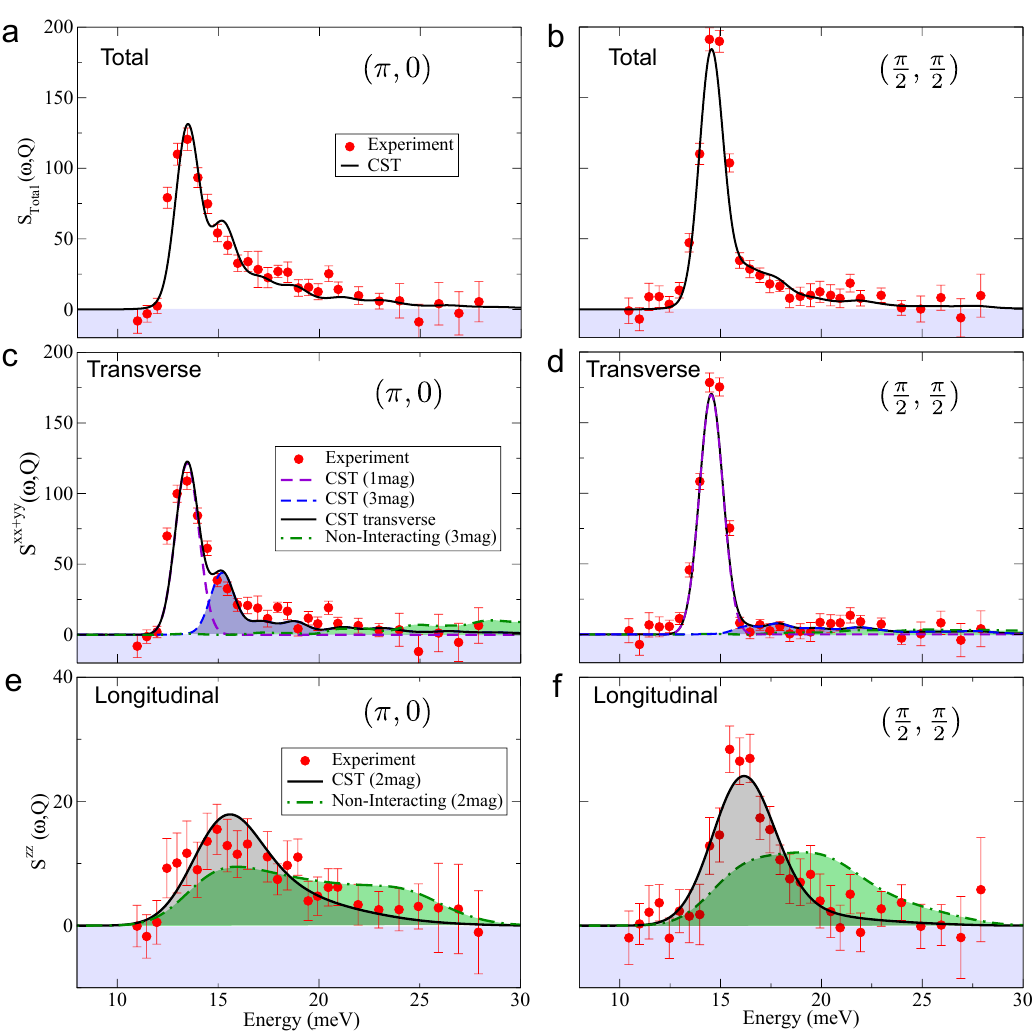
Figure 4: Dynamic structure factors. Comparison between the DSFs measured in Ref. [ 16 ] and the theoretical line shapes obtained from the CST. The energy scale is set to J = 6.11 ( 2 ) meV for all curves. The arbitrary units on the y -axis are fixed globally to match the experimental data. The lattice constant is set to unity. ( a ) Total DSF (sum of transver- π π ) . ( c ) Transversal DSF sal and longitudinal part) at k = ( π ,0 ) . ( b ) Total DSF at k = ( , 2 2 at k = ( π ,0 ) . The magenta line shows the dominant one-magnon peaks. The transversal = 0.58 ( 2 ) meV. The three-magnon continuum is shown as blue curve. broadening is set to σ t Omitting the interaction leads to the green curve which does not agree with experiment at all. π π ) ; otherwise same as in panel ( c ). ( e ) Longitudinal DSF at ( d ) Transverse DSF at k = ( , 2 2 = 1.41 ( 5 ) meV to match the experimental k = ( π ,0 ) . The longitudinal broadening is set to σ l data. The black line depicts the two-magnon continuum; the four-magnon contribution is neg- ligible. The green line results from omitting the magnon-magnon interaction. ( f ) Longitudinal π π ) ; otherwise same as in panel ( e DSF at k = ( , 2 2